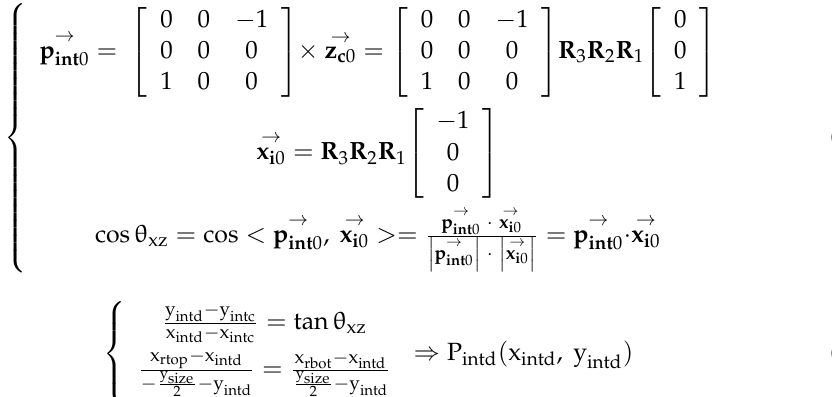
Figure 11. The imaging for the calculation of θ y . The right lane l r is detected in the IMG plane. Since Oc”-Xc”Yc”Zc” is defined by rotating Oc’-Xc’Yc’Zc’ around the Yc’-axis, the Zc”-axis is in the Xc’Zc’-plane and the line P intc P intd is the line of intersection of the IMG plane and the Xc’Zc’-plane. Therefore, the angle θ xz between the unit vector p int0 of the line P intc P intd and the unit vector x i0 of the Xi-axis can be calculated as shown in (7), using the rotation matrices R 1 , R 2 , and R 3 calculated in Section 2 when p int0 is perpendicular to the unit vector z c0 of the Zc-axis. Then, P intd can be calculated as the intersection point of the detected l l or l r and the line P intc P intd as in